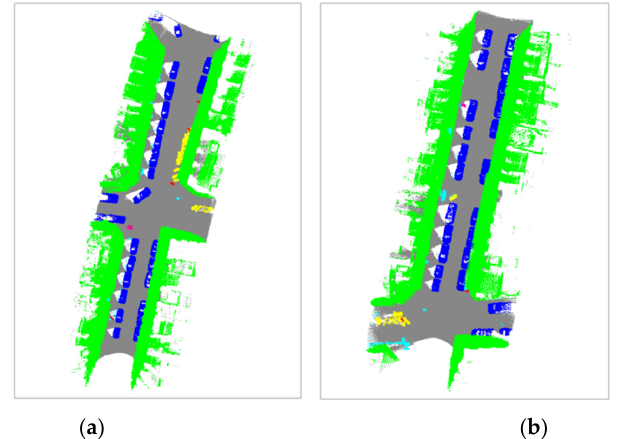
Figure 11. The street view in the area A ( a ) and area B ( b ). Note: Vehicles in dark blue, other objects in different colors (buildings in green, motorcycles in yellow, ground in gray, trash cans in red, others in light blue).